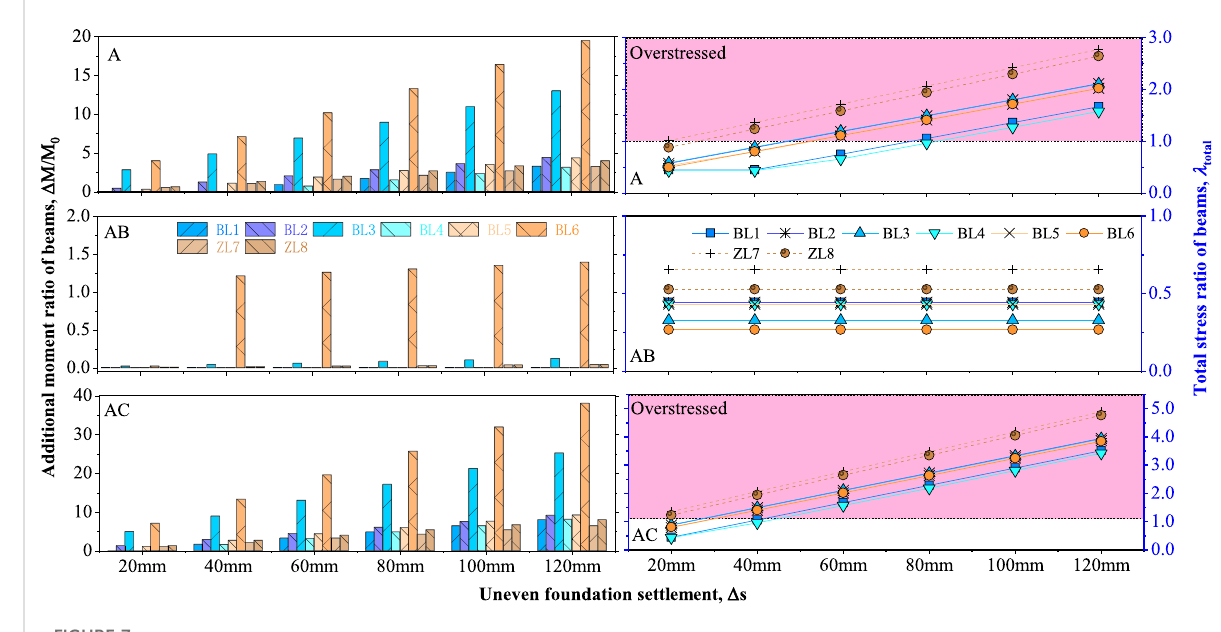
FIGURE 7 Additional stress of beams under uneven foundation settlement.